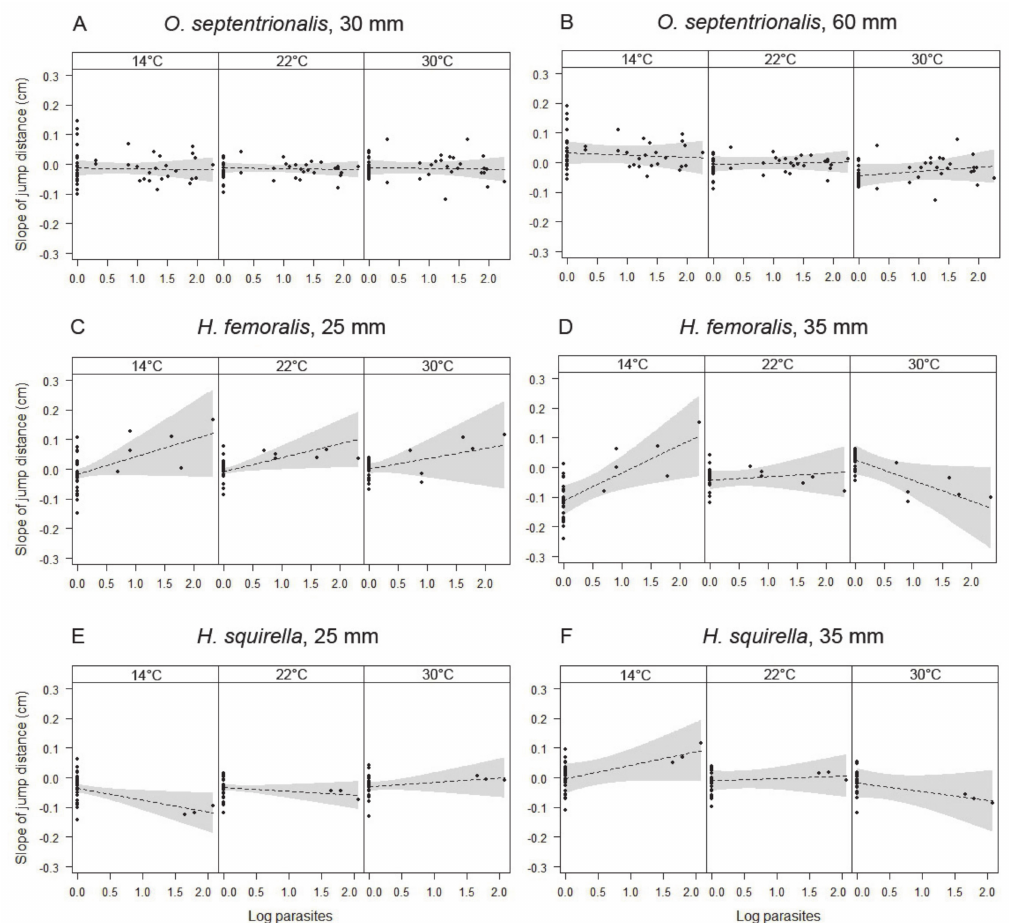
Figure 4. Interactive effects of species, snout-vent length (SVL), temperature, and log 10 parasite load on the endurance of frogs (slope of jump distance against jump number) for ( A , B ) O. septentrionalis , ( C , D ) H. femoralis , and ( E , F ) H. squirella . For each species, relationships are shown for frogs with small and large body sizes (20th and 80th percentiles). These plots are conditional plots with fitted regression line (dotted line), partial residuals (dots), and 95% confidence bands (shaded) that control for all factors in the statistical model that are not shown in the figure (see Table